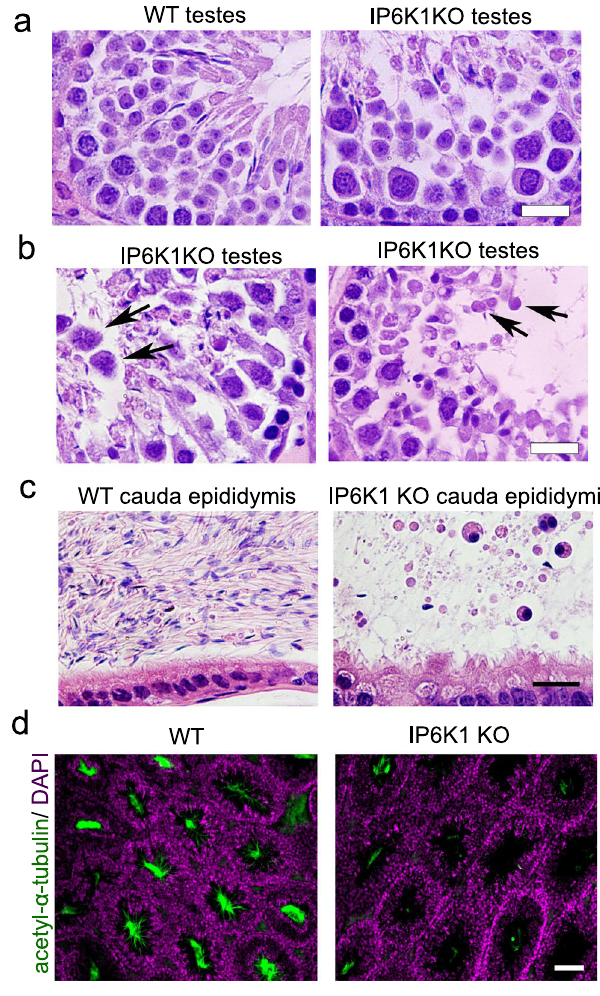
Figure 2. Deletion of IP6K1 elicited sloughing of round germ cells. ( a,b ) H&E staining of testes ( a ) Germ cells in IP6K1 KO seminiferous tubules are more loosely connected to Sertoli cells. Scale bar 20 μ m. ( b ) Round germ cells were sloughed off and appeared in the lumina of seminiferous tubules (arrows). Scale bar 20 μ m. ( c ) H&E staining of cauda epididymides. Round germ cells were seen in IP6K1 KO cauda epididymides. scale bar 20 μ m. ( d ) Immunostaining of sperm tails in testes with anti acetyl- α -tubulin antibody; DAPI stains nucleus. Scale bar 100 μ